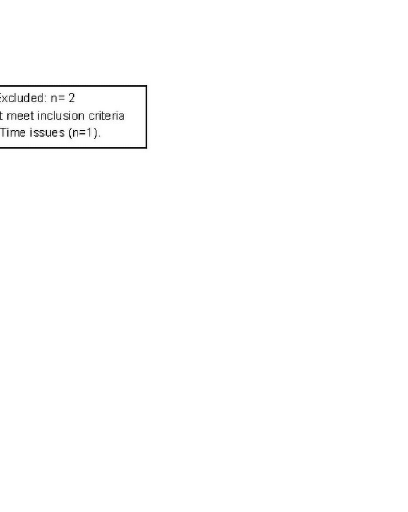
Fig 1. Subject screening, enrollment, and study flow